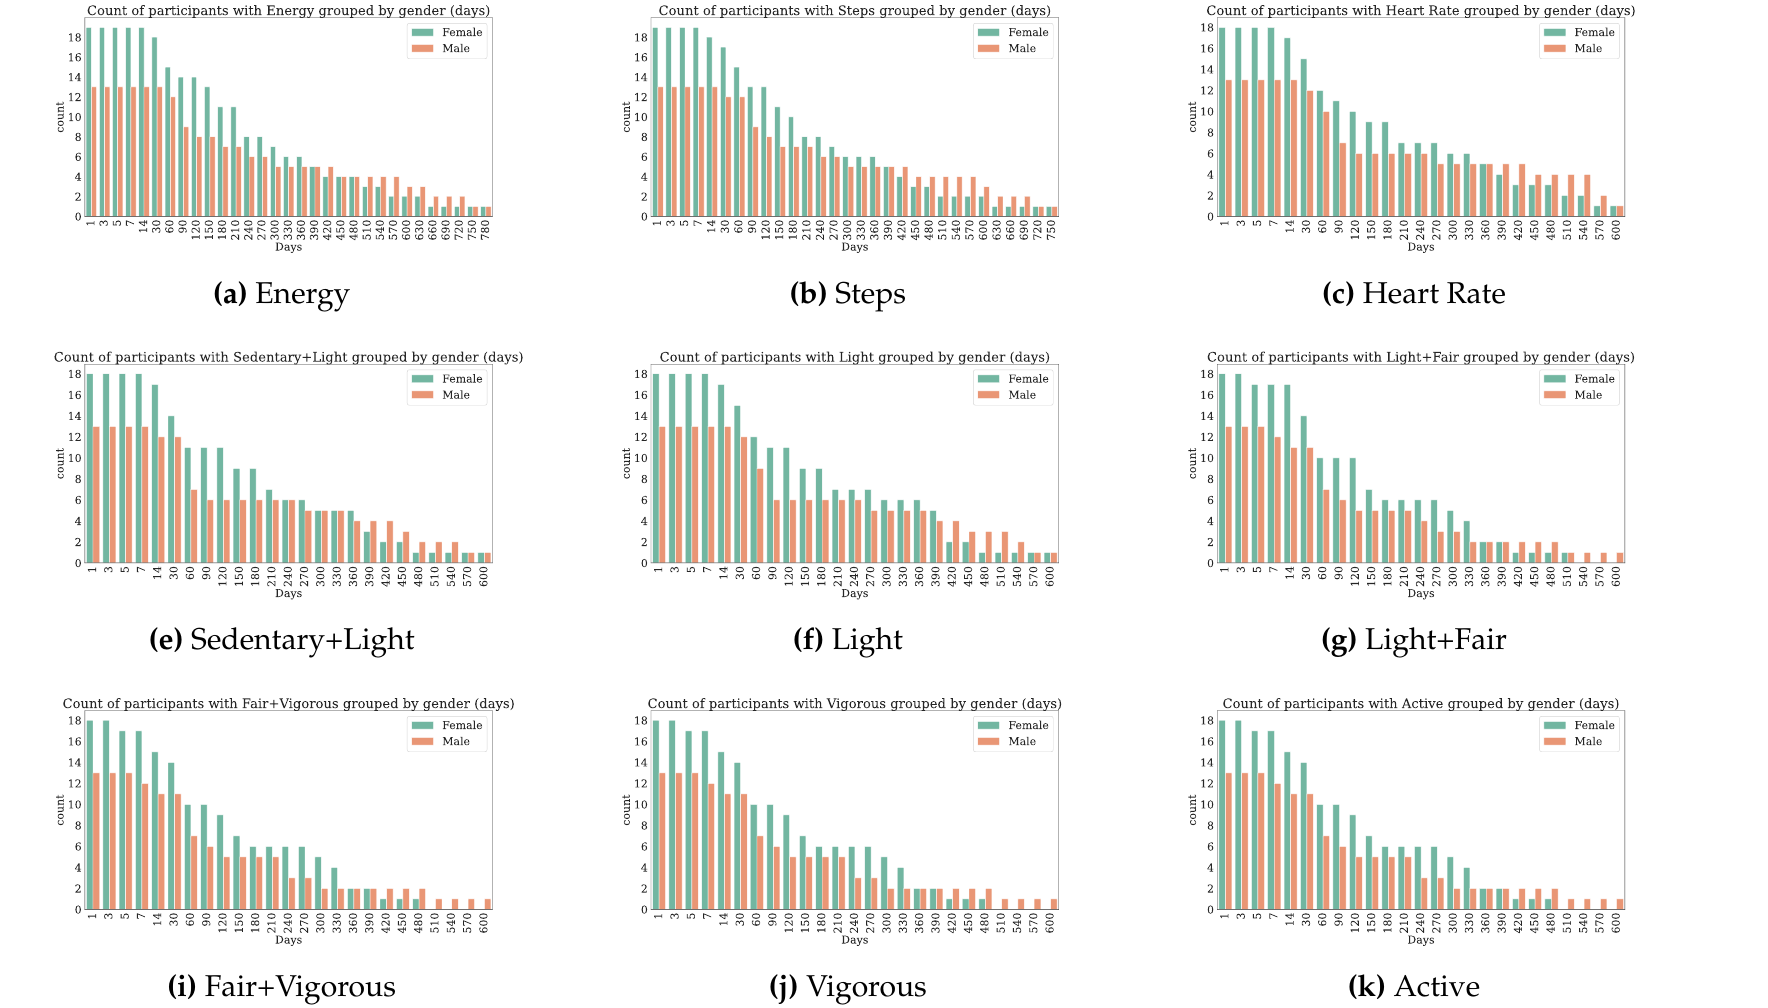
Figure A15. Count of seniors with at least the given valid days of Fitbit (TechRO) by outcome and gender group